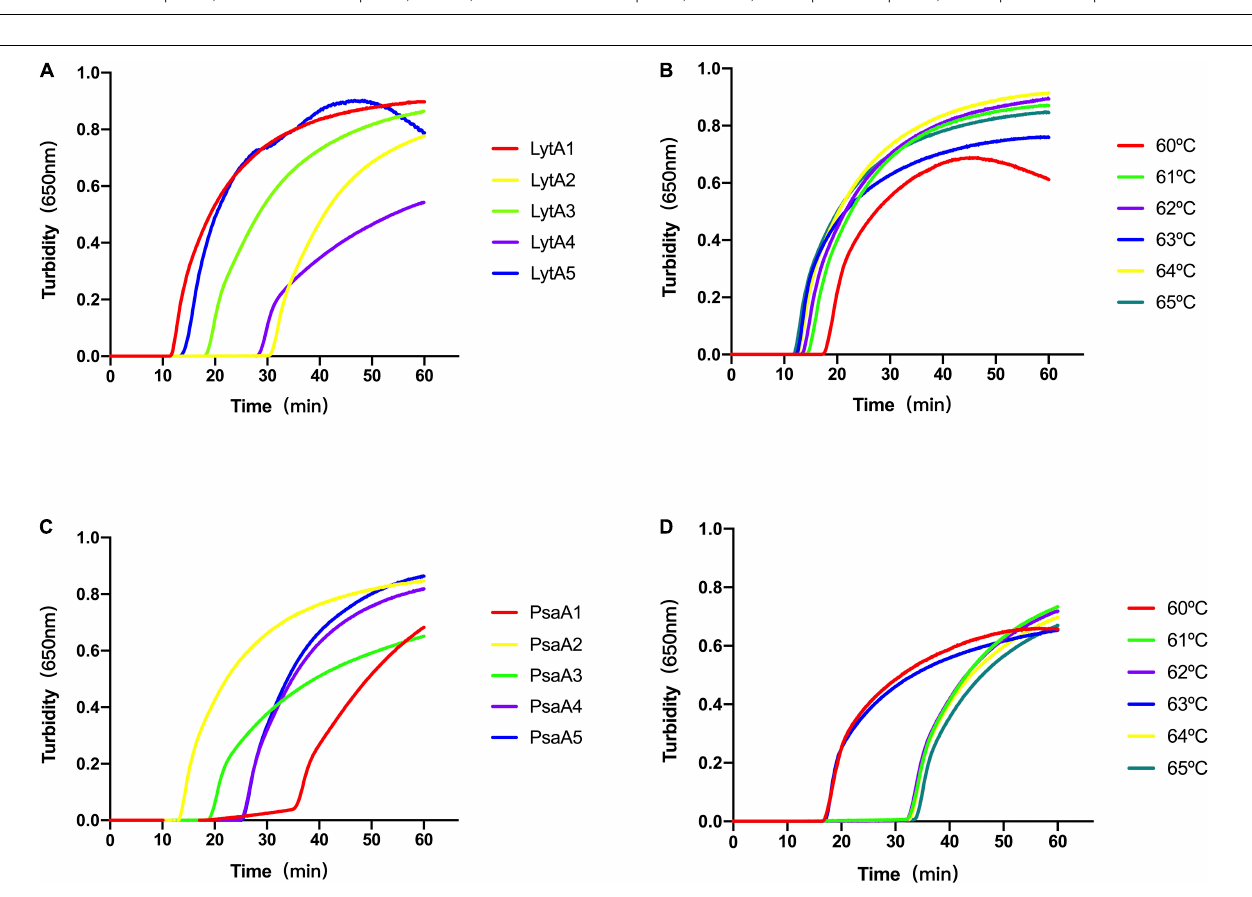
FIGURE 1 | Selection of specific regions and primer positions. (A) Primers to amplify the lytA gene. (B) Primers to amplify the psaA gene. F3: outer forward primer; B3: outer backward primer; FIP: forward inner primer, F1c-F2; BIP: backward inner primer, B1c-B2; LF: loop forward primer; LB: loop backward primer.